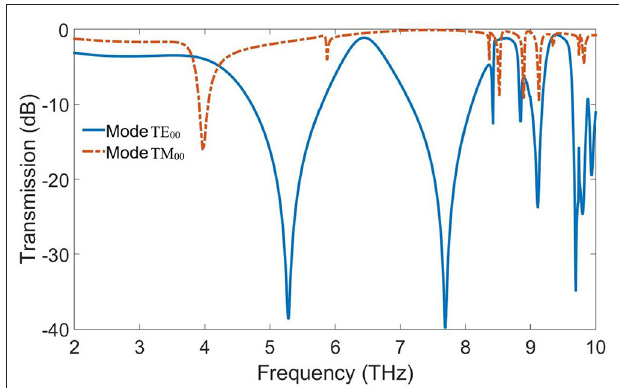
FIGURE 4 | Shifted resonances according to the change in the dielectric constant of the analyte. The range of investigated permittivities is between 1 and 2.2 for the analyte. The permittivity of ε r = 1 is considered as the reference resonance curve. For ε r = 2.4, the resonances reach their saturation state, and there are no further resonance frequency shifts for higher